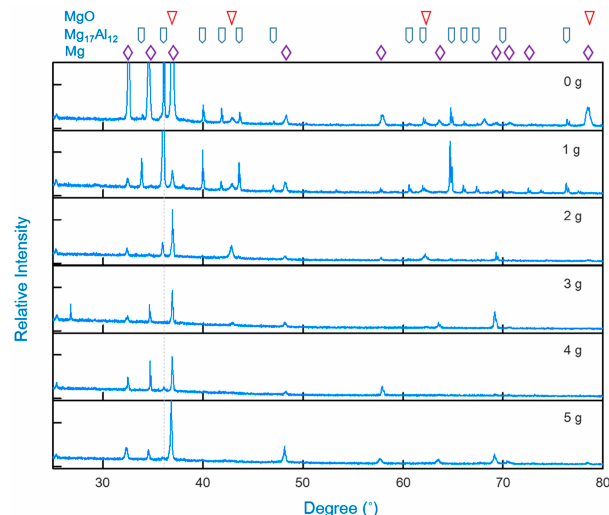
8 Figure 8. The x-ray di ff raction (XRD) patterns of specimens which underwent various di ff usion alloying processes with an NH 4 Cl content of 1, 2, 3, 4, 5 g, respectively in the di ff usion source. The triangles, pentagons, and quadrangles mark characteristic peaks of MgO, Mg 17 Al 12 and Mg respectively.